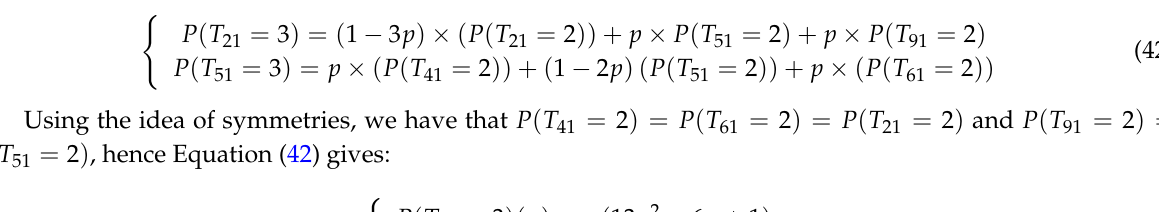
Figure 11 render the movement of the biological molecule from sate j > 1 to state 1 in three steps. In